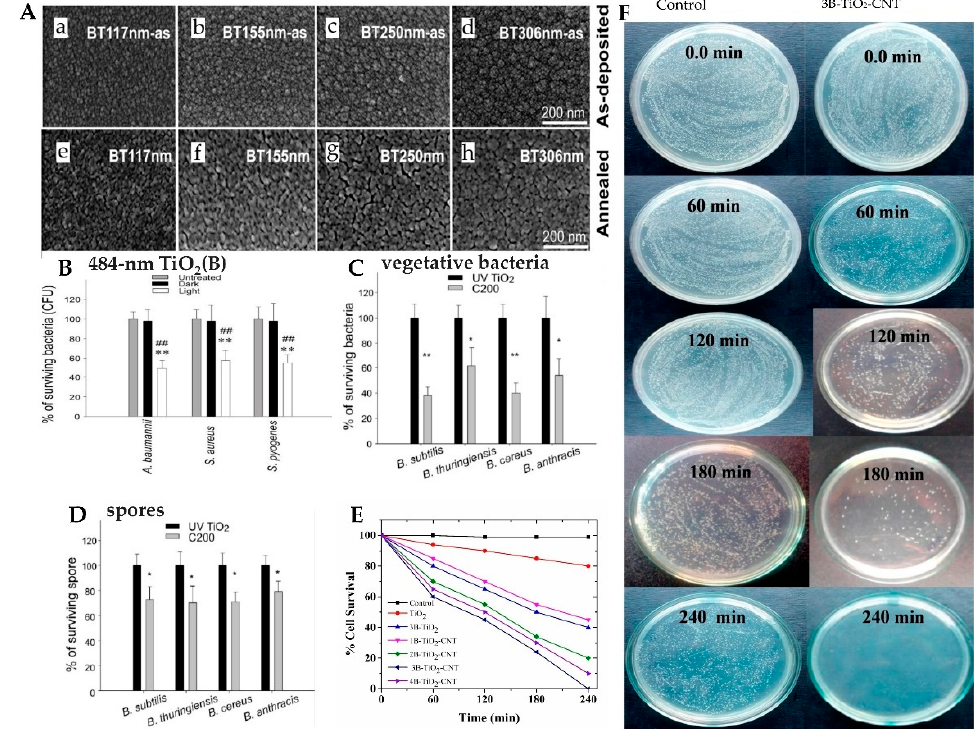
Figure 7. ( A ) SEM image of TiO 2 ( B ) films with various thicknesses before ( a – d ) and after ( e – h ) annealing; ( B ) visible light-induced photolytic killing of pathogenic bacteria [66]; ( C ) antibacterial properties of C200 NPs against vegetative bacteria of Bacillus species; ( D ) antibacterial properties of C200 NPs against spores of Bacillus species [67]; ( E ) % survival of E. coli with TiO 2 TiO 2 TiO 2 different samples as a function of time under visible light; ## p < 0.01, ** p < 0.01, * p < 0.05. ( F ) photographs of the photoinactivation of E. coli under visible light exposure [69].